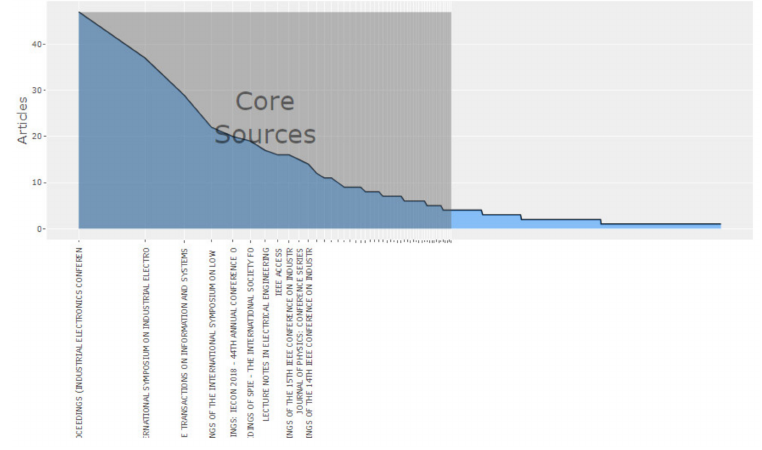
Figure 6. Bradford’s Law according to Scopus.